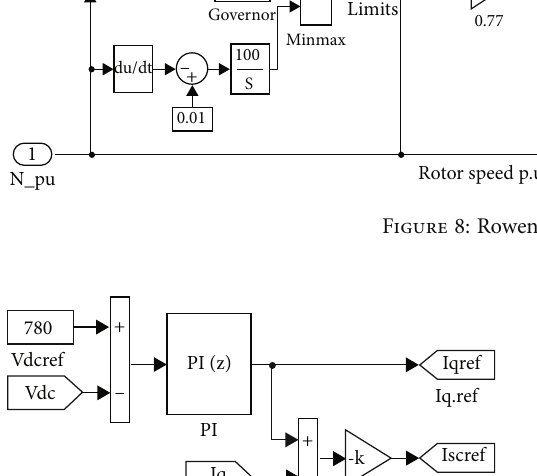
Figure 9: Coordinated control scheme of the AC-DC recti fi er and